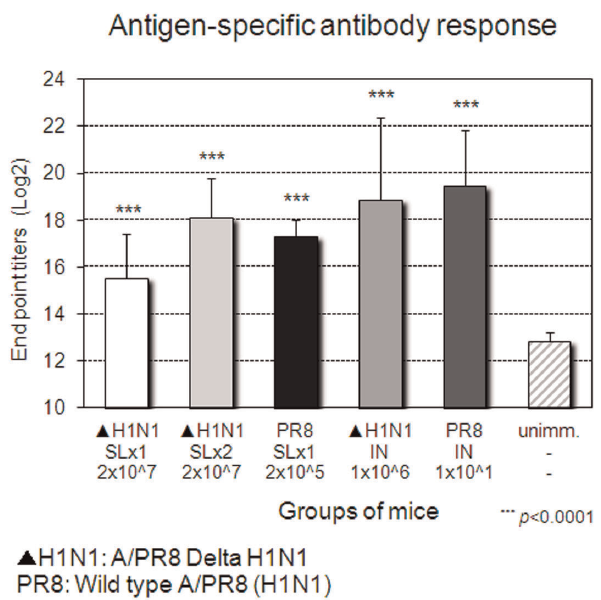
Figure 4. Induction of HI Abs upon immunization with Delta H1N1. On the day before challenge as described in Figure 3, the sera were collected and the titers of HI Abs were determined against A/PR8 virus. The values represent the mean + SEM antibody titers of sera from